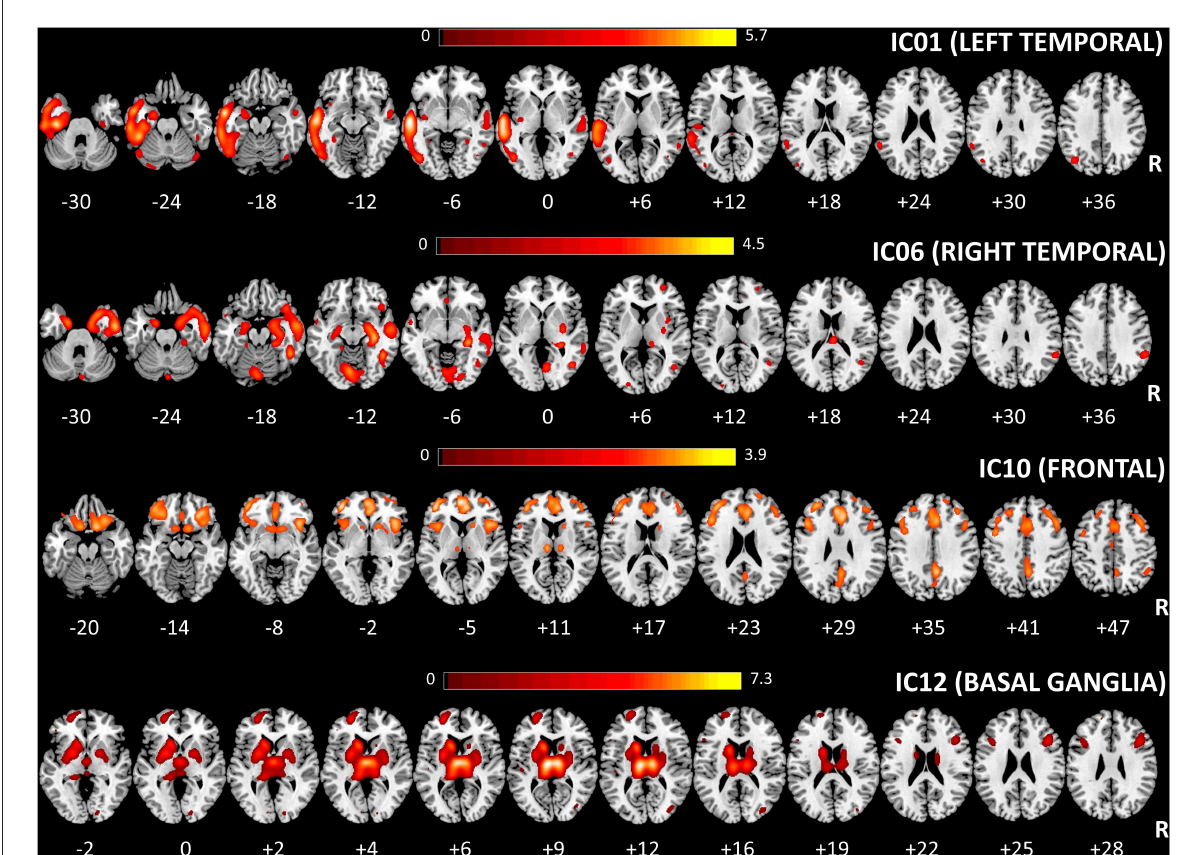
FIGURE2 Spatial maps of the four considered sources for multivariate SBM analysis are shown, superimposed on an axial T1 MRI standard template (MRIcron, https://www.nitrc.org/projects/mricron). The number under each slice represented the standardized z coordinate. Voxels above the threshold of |Z| > 2.0 are shown. R, right; SBM, source-based morphometry.